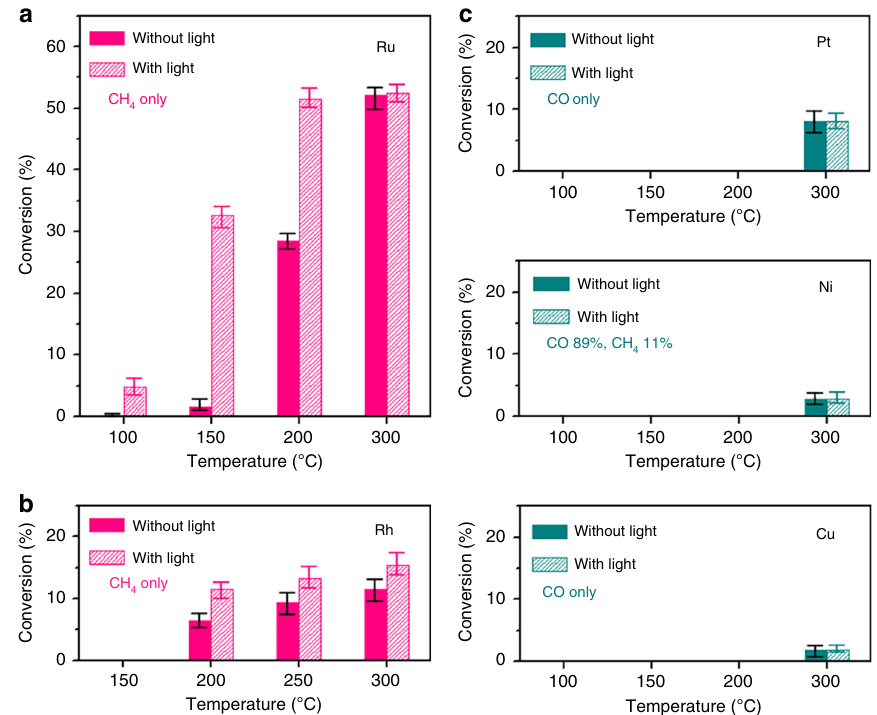
Fig. 1 Light enhancement on metal catalysts. CO 2 conversion for CO 2 hydrogenation on a Ru, b Rh, and c Pt, Ni, and Cu catalysts deposited onto silica with and without light irradiation. 0.5 vol% CO 2 /N 2 (50 sccm) and H 2 (1.5 sccm) was fed into the reactor through a static mixer with or without light irradiation. A Xe lamp with light intensity of 35 mW cm − 2 was used with a water-circulating fi lter to exclude any thermal effect from the light source. The error bar indicates the deviation among three independent measurements